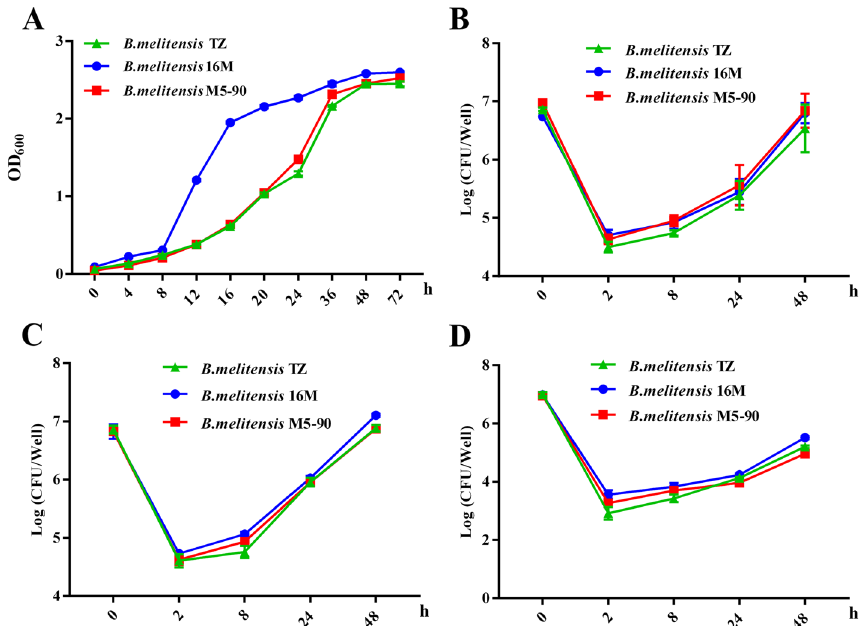
Fig. 5 Growth kinetics of the B. melitensis TZ strain in pure culture and infected cell lines. A Growth characteristics of B. melitensis TZ, B. melitensis 16 M and B. melitensis M5-90 in TSB. The optical density was obtained every 4 h before 24 h and at 36 h, 48 h, and 72 h with three repetitions. B Intracellular replication of B. melitensis TZ, B. melitensis 16 M and B. melitensis M5-90 in infected RAW 264.7 cells. C. Intracellular replication of B. melitensis TZ, B. melitensis 16 M and B. melitensis M5-90 in infected THP-1 cells. D. Intracellular replication of B. melitensis TZ, B. melitensis 16 M and B. melitensis M5-90 in infected HeLa cells. The level of initial infection was the same for all B. melitensis strains as described in the Materials and Methods. At 0, 2, 8, 24, and 48 h postinfection, infected macrophages were lysed, and supernatants were diluted for CFU